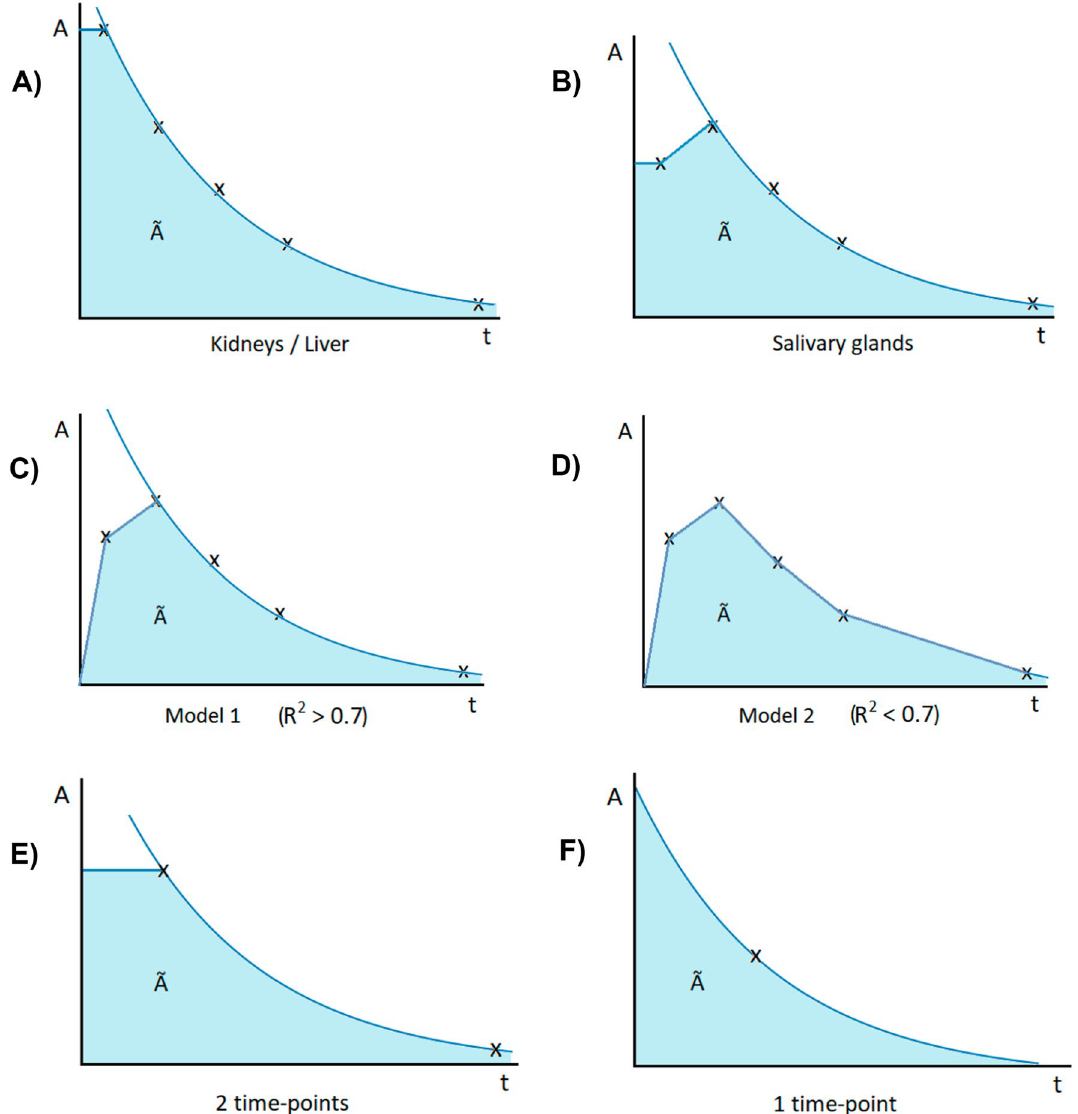
Fig. 1 Fitting schemes for the five-time point reference standard protocol for kidneys and liver ( A ), salivary glands ( B ), lesions ( C or D depending on R 2 ), and for the simplified protocol using two time points ( E ) or one-time point ( F